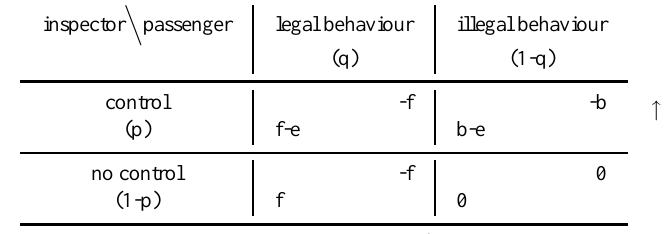
Table 1. Normal form of the two person game between the inspector representing the MVV and the passenger. The arrows indicate the preference directions of the two players. (cid:0) inspector / passenger legal behaviour illegal behaviour (q) #